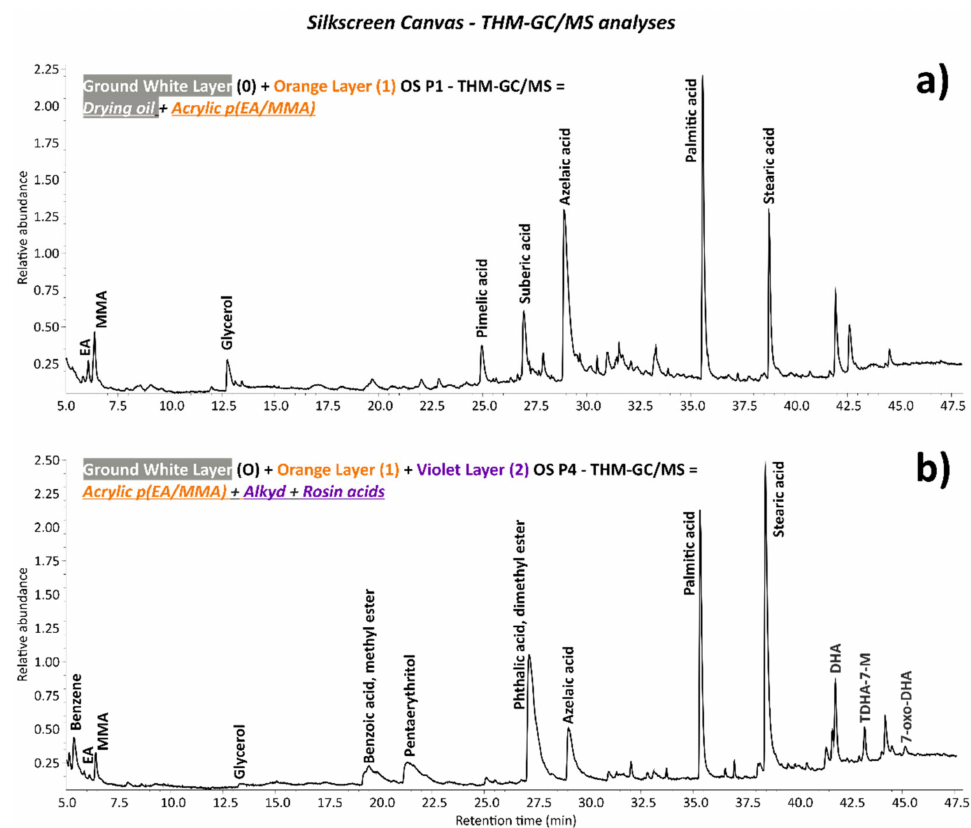
Figure 13. ( a ) Pyrogram of the white 0 and orange 1 layers of the OS P1 sample acquired by TMH– GC/MS showing the most important marker peaks of a drying oil binder (glycerol, pimelic acid, suberic acid, azelaic acid, palmitic acid, and stearic acid) and the EA and MMA peaks of an EA/MMA acrylic binder. ( b ) Pyrogram of the white 0, orange 1, and violet 2 layers of the OS P5 sample acquired by TMH–GC/MS showing the most important marker peaks of a drying oil binder (glycerol, azelaic acid, palmitic acid, and stearic acid), the EA and MMA peaks of an EA/MMA acrylic binder, and the benzene, benzoic acid, methyl ester, pentaerythritol, dimethyl ester, azelaic acid, palmitic acid, and stearic acid peaks of an alkyd binder. Additionally, the marker peaks of rosin acids such as DHA (dehydroabietic acid), TDHA-7-M (tetradehydroabietic acid, 7-methoxy), and 7-oxo-DHA (7-oxodehydroabietic acid) are shown.